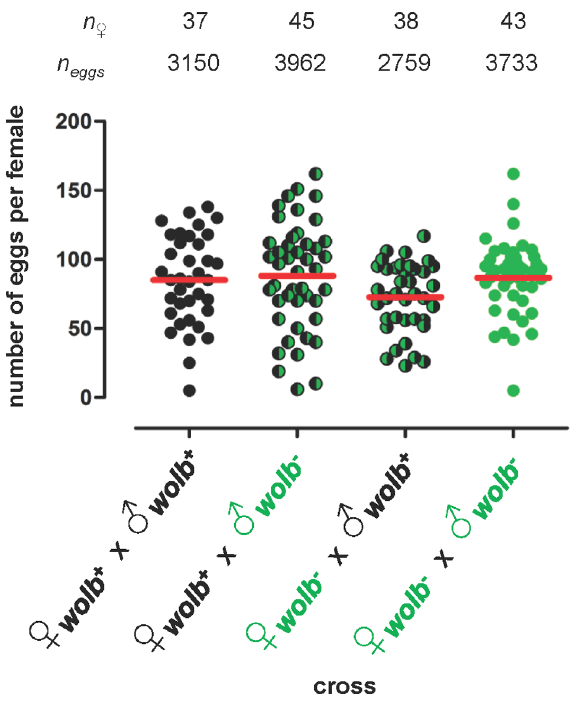
Figure 3. w Flu has no effect on the fecundity of female Ae. fluviatilis . Graph showing the number of eggs laid in reciprocal crosses between the wildtype ( wolb + ) and antibiotic-treated ( wolb 2 ) strains of the mosquito Ae. fluviatilis . Each circle represents a single adult female mosquito, while the red horizontal bars indicate the mean number of eggs per female. The data shown are from the same two experiments presented in Figure 1. The total number of eggs laid per female did not differ significantly between the four reciprocal crosses (ANOVA, F (3, 159) =2.008, P =0.115).